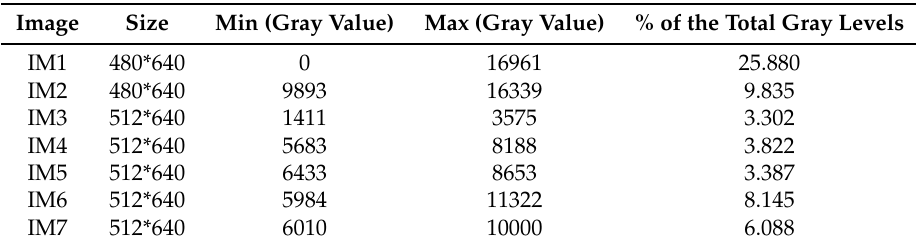
Table 1. Basic information of the test